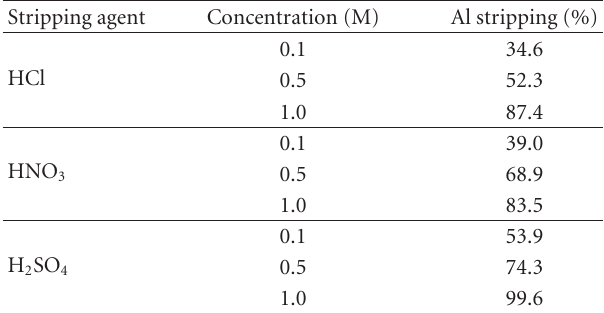
Table 1: E ff ect of stripping agents on stripping e ffi ciency of Al from loaded organic (L.O; 6.47